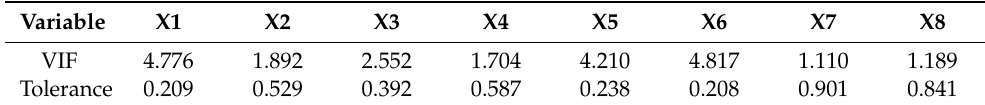
Figure 2. Analysis framework of land urbanization in Yangtze River Delta urban agglomeration. All independent variables were standardized and tested for multicollinearity using the variance inflation factor (VIF) before running the MGWR model. The larger the VIF value, the greater the multicollinearity [77]. It is generally believed that if the VIF value is greater than 7.5 or the tolerance (the reciprocal of VIF) is closer to 0, it indicates that the multicollinearity is stronger. The VIF value of each index was less than 7.5 (Table 2), indicating no multicollinearity problem among the selected indexes. Table 2. Influencing factors multicollinearity test.